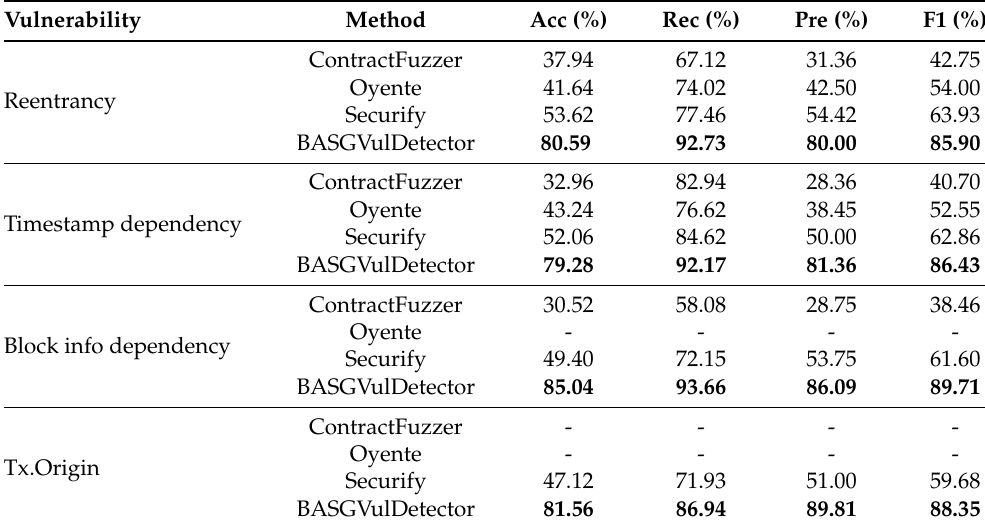
Table 4. Performance comparison for BASGVulDetector (‘-’ denotes not applicable).